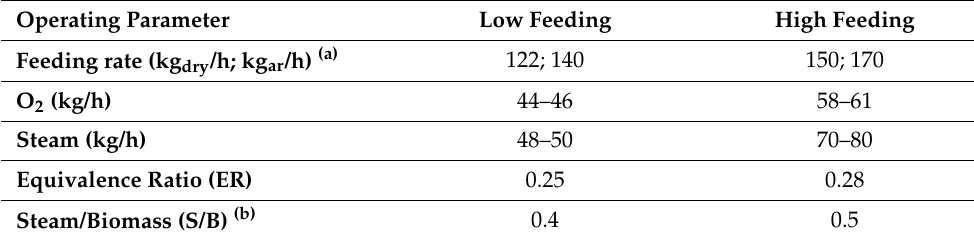
Table 3. Gasification operating conditions in test of low and high biomass feeding rate. Operating Parameter Low Feeding High